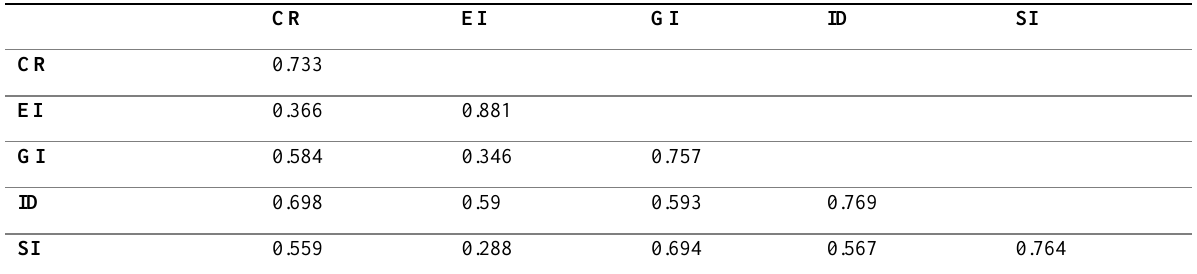
Table 3: Discriminant validity (Fornell-Larcker